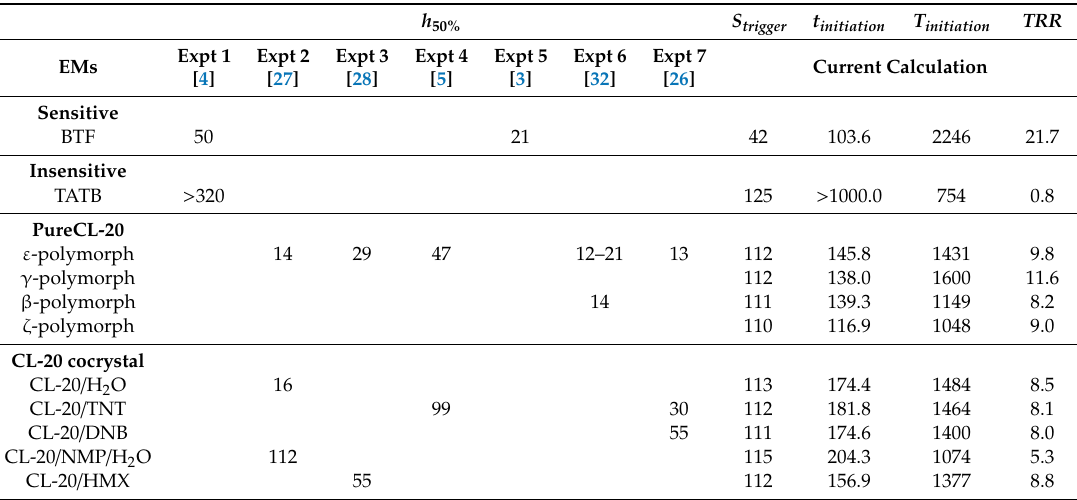
Table 2. The experimental h 50% (cm) values and the initiation time of the shock reaction t initiation (fs) of the 11 EMs studied. The strength of the trigger bond S trigger (kcal / mol), the temperature T initiation (K) and the temperature rising rate TRR (K / fs) for each crystal are also given for the study of the mechanism of the shock reaction initiation. h 50% S